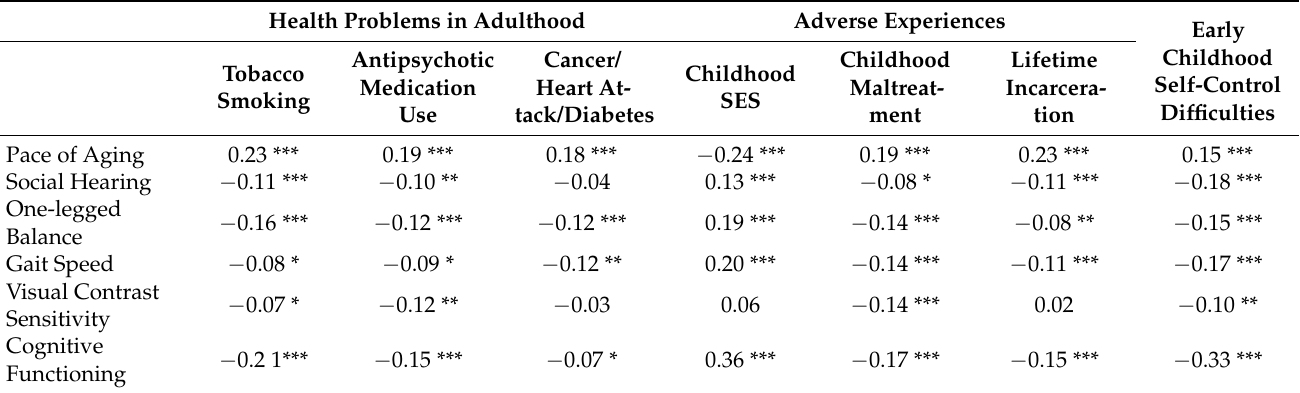
Table 3. Correlations between midlife aging outcomes and health problems in adulthood, adverse experiences and self-control difficulties (n =